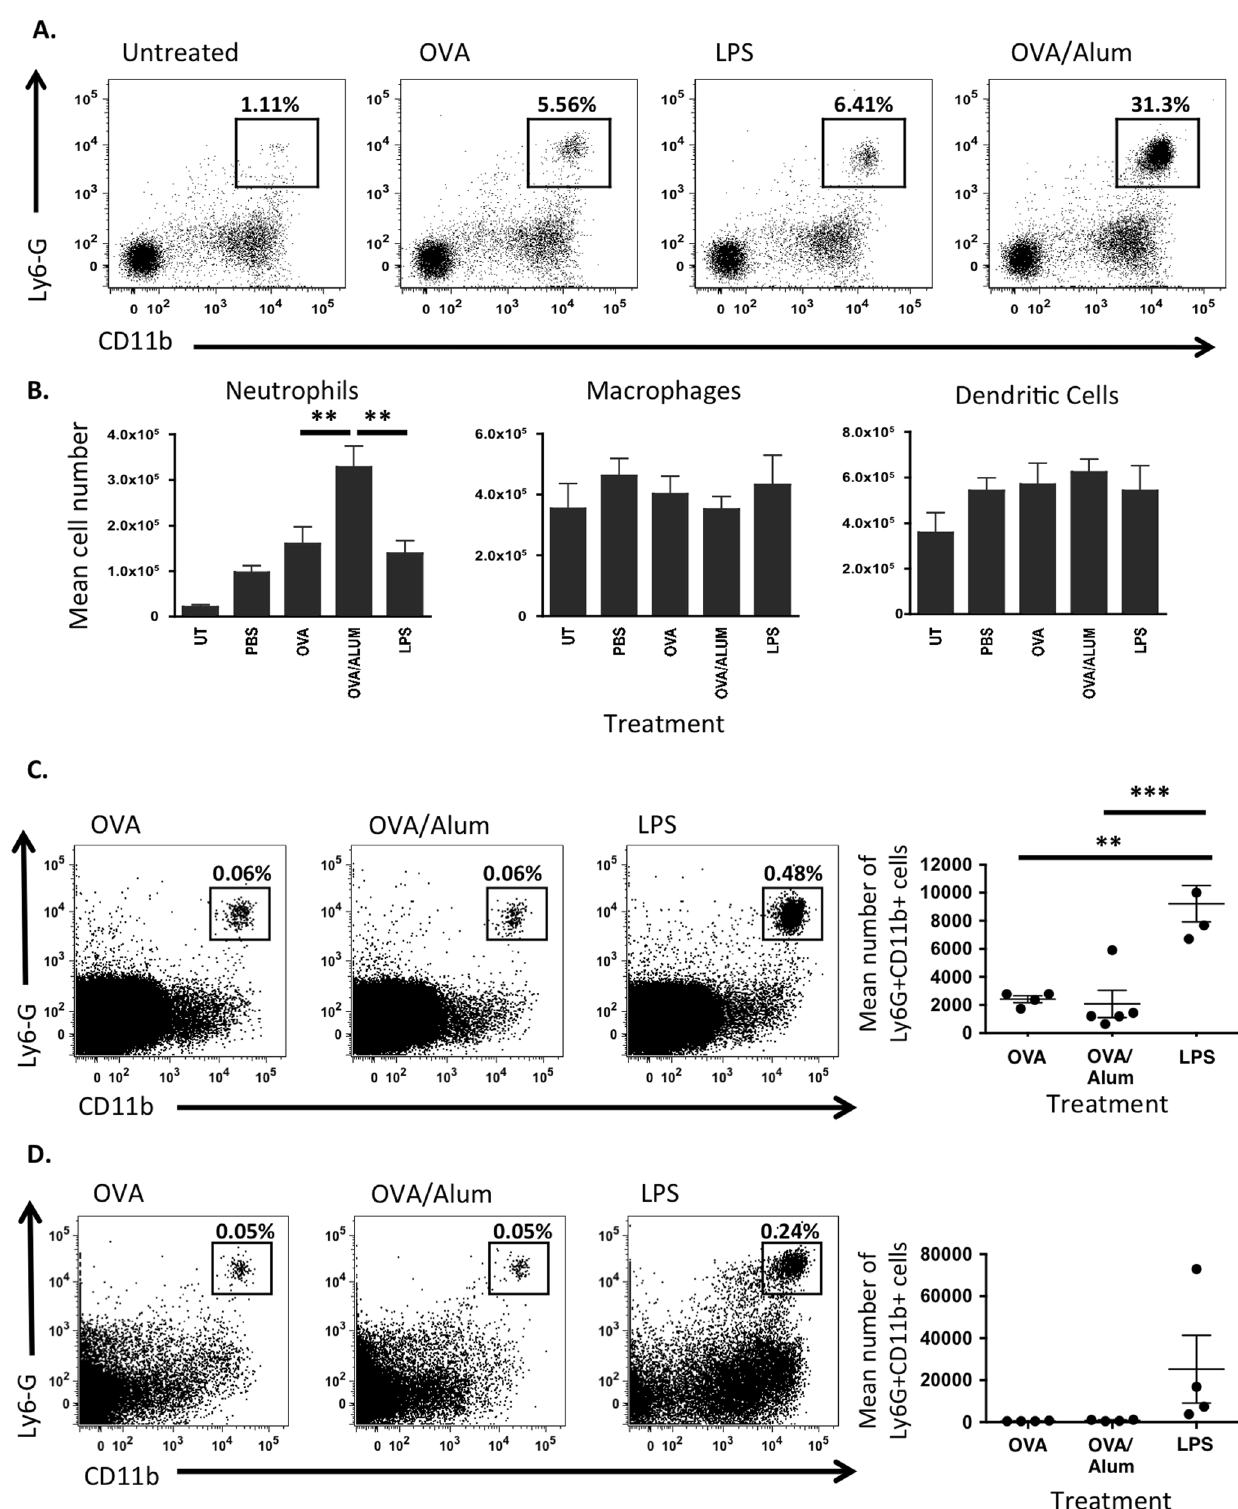
Fig. 1 Alum induces neutrophil recruitment at the site of immunisation but not at the dLN within 2 h. a Representative fl ow cytometry plots depicting the recruitment of Ly6G + CD11b + neutrophils to the site of alum immunisation. b Mean number ( ± SEM) of Ly6G + neutrophils, F4/80 + macrophages and CD11c + dendritic cells recruited within 2 h to the alum injection site (UT; Untreated, PBS; PBS-injected). Groups contained six animals and data are representative of three independent experiments. c Representative fl ow cytometry plots and bar charts depicting the mean number of Ly6G + CD11b + neutrophils ( ± SEM) recruited to the draining cervical LN 2 h and d 24 h post immunisation. Groups contained three to fi ve animals and data are representative of three independent experiments. ** P < 0.01, *** P < 0.001